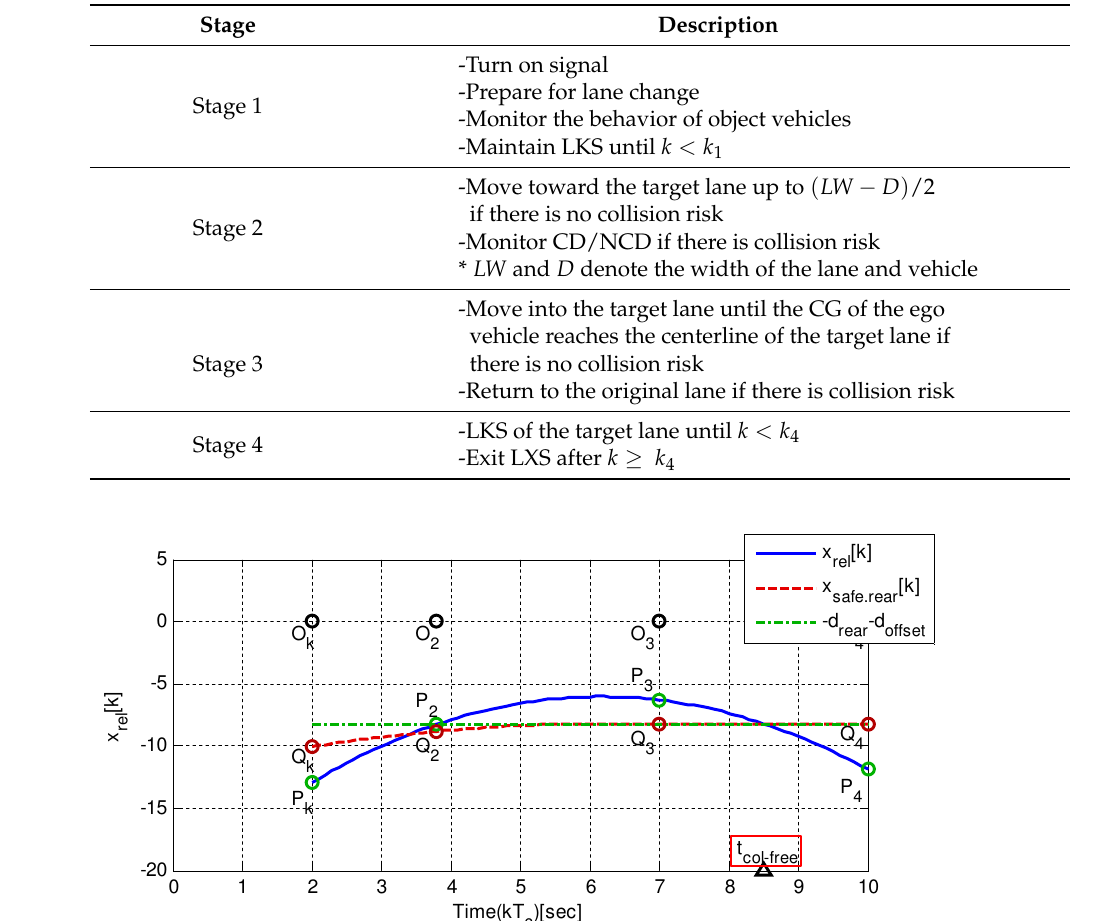
Table 1. Description of stages.